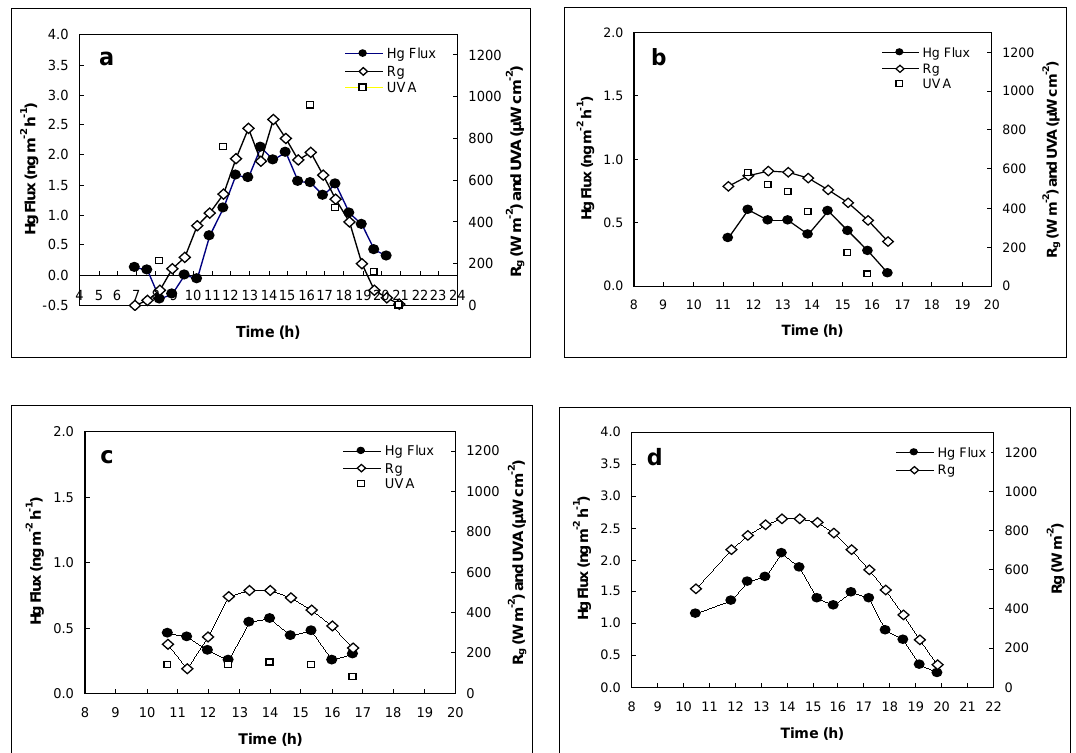
Figure 2. Examples of the daily variations of the Hg air / water exchange fluxes obtained at Cane Creek Lake (TN, USA) in ( a ) the summer (August 4), ( b ) fall (November 5), ( c ) winter (January 21), and ( d ) spring (April 4) ( R g : global solar radiation, UVA: ultraviolet A radiation).